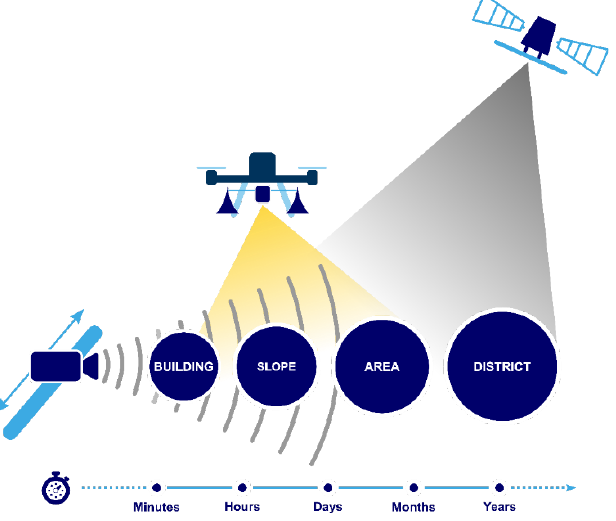
Figure 1. Complementarity of UAS-borne radar with terrestrial and spaceborne systems.